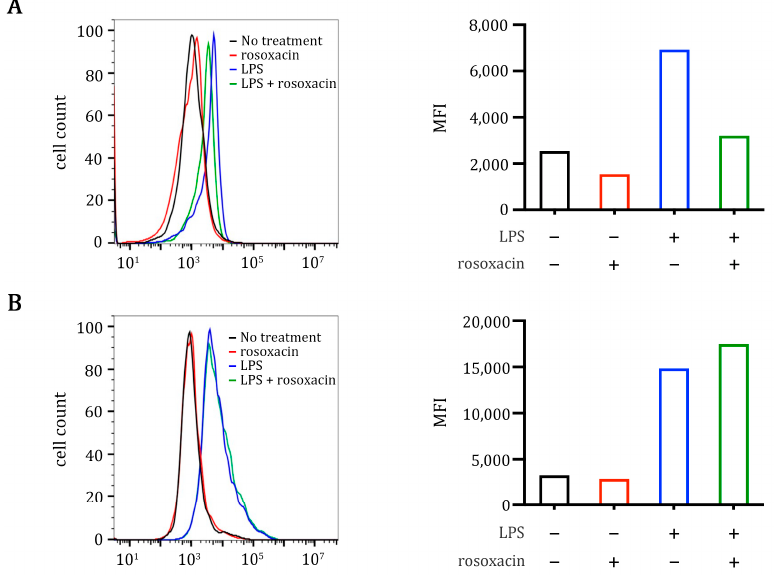
Figure 5. Rosoxacin reduced class II MHC on antigen-presenting cells. RAW 264.7 macrophages were unstimulated (PBS-treated) or stimulated by LPS, followed by rosoxacin treatments. The expressions of class II MHC ( A ) and CD80 ( B ) on the RAW264.7 cells were determined by flow